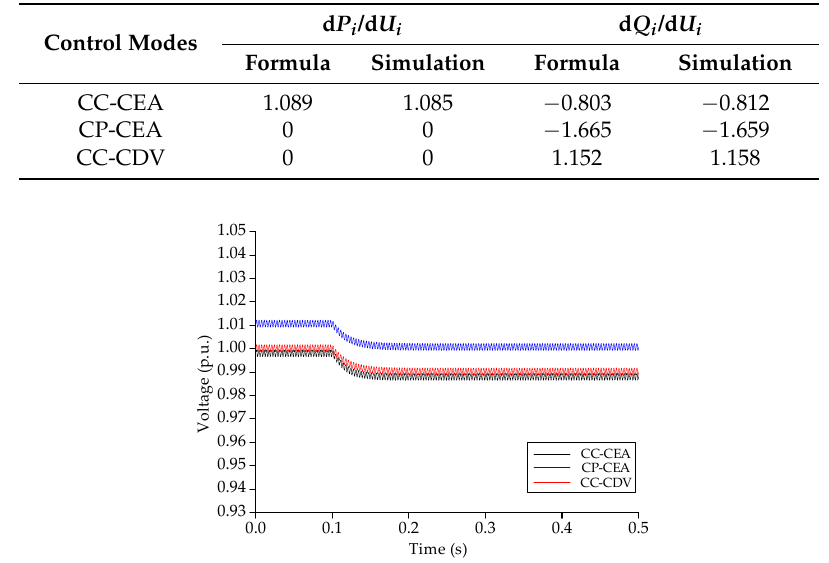
Figure 9. Change of power injection into converter bus under different control modes. ( a ) active power; ( b ) reactive power. The control mode of HVDC system j is CC-CEA, and the voltage of converter bus is operating under rated value. To facilitate the comparative study, the ratio of Z ij and Z jj is maintained constant (i.e., / = 0.5 ij jj Z Z ) while the effective short-circuit ratio ( ESCR j ) at converter bus j maintained at 4 and the effective short-circuit ratio ( ESCR i ) at converter bus i varied from 3 to 6, which means that the MIIF ij obtained by the equivalent impedance ratio method is always equal to 0.5 regardless of the values of ESCR i . In the case of different control modes of HVDC system i , the simulation calculation method based on definition and the analytic method proposed in this paper are used to calculate MIIF ij with the ESCR i varied from 3 to 6, respectively. It is noted that the values of MIIF can be obtained by substituting the calculation results of sensitivities in Table 1 into Equation (56) when using the proposed analytical method. Table 2 shows the MIIF calculation results obtained by the three methods under different scenarios and the relative errors of the proposed analytic method and the equivalent impedance ratio method by means of simulation method as control group.